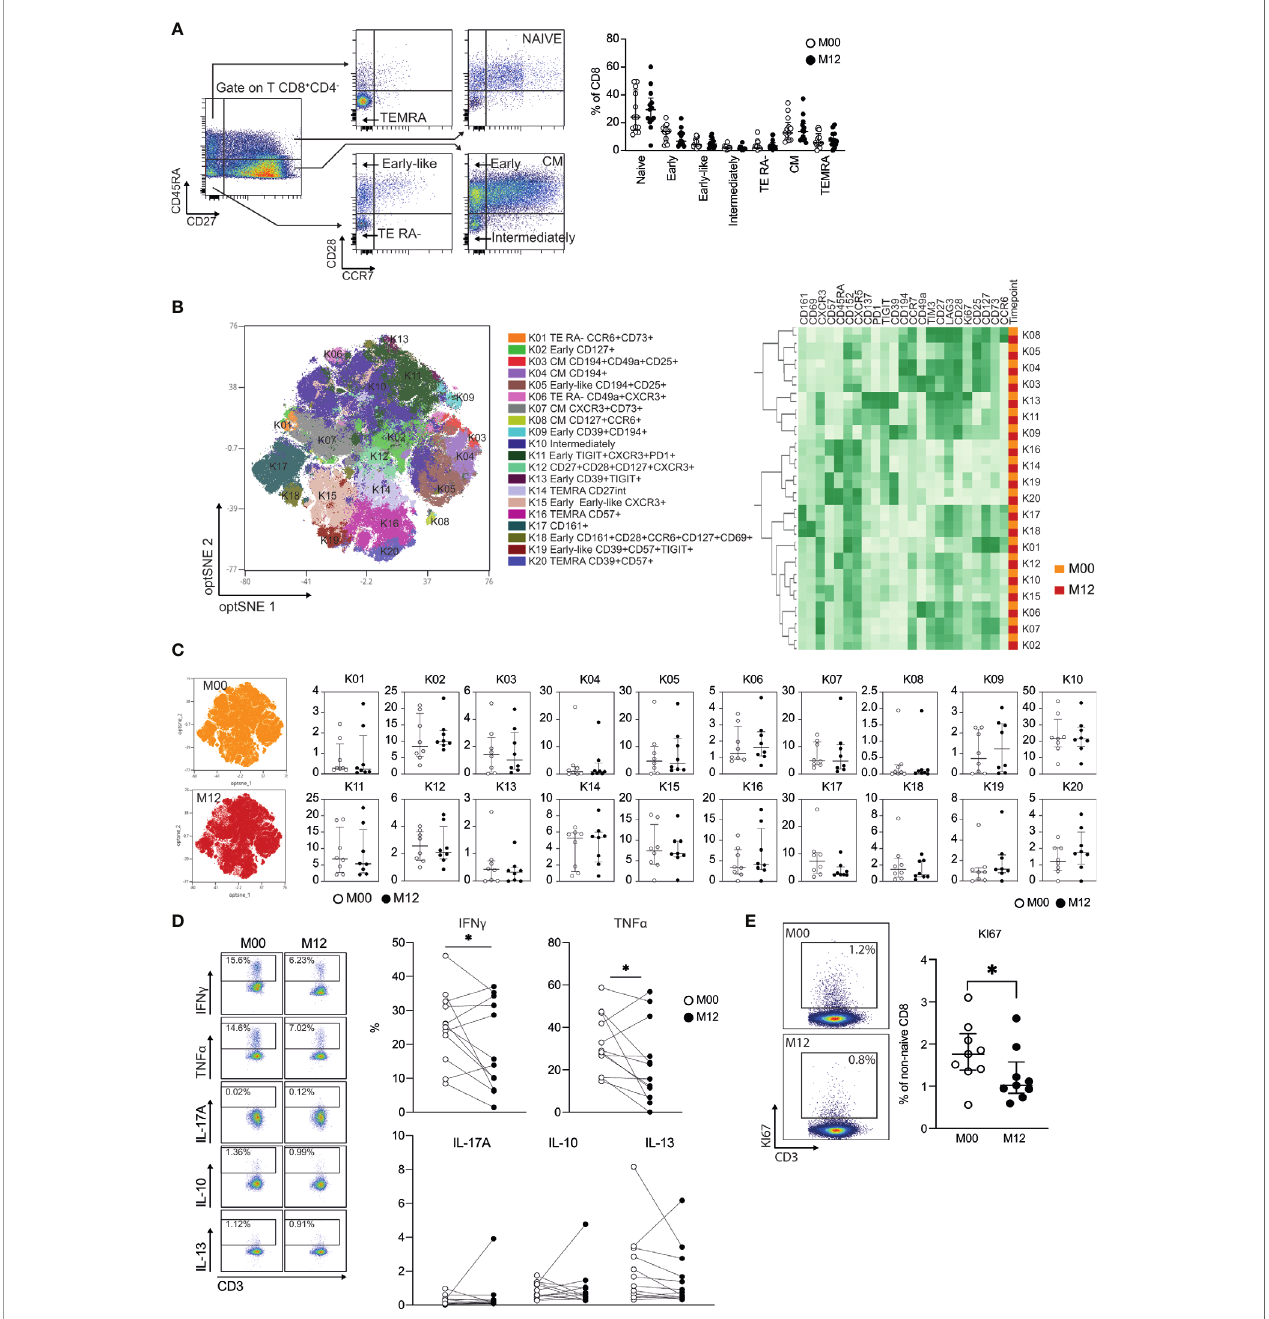
FIGURE 2 | Teri fl unomide speci fi cally reduces the proliferation and immune function of CD8 T cells in patients with RRMS. (A) Frequency of CD8 T cell subsets in patients with RRMS at baseline (white) or 12 months post-teri fl unomide treatment (black; n=13). The gating strategy is shown after initial gating of CD19 - CD56 - CD3 + TCR gd - CD8 + CD4 - cells (TEMRA, CD45RA + CD27 - CCR7 - CD28 - ; NAÏVE, CD45RA + CD27 + CCR7 + CD28 + ; early-like, CD45RA - CD27 - CCR7 - CD28 + ; EM RA-, CD45RA - CD27 - CCR7 - CD28 - ; early, CD45RA - CD27 + CCR7 - CD28 + ; intermediate, CD45RA - CD27 + CCR7 - CD28 - ; CM, CD45RA - CD27 - CCR7 + CD28 + ). (B) optSNE projection of non-naïve ab CD8 T cell clusters identi fi ed by FlowSOM metaclustering (left) and mean fl uorescence intensity (MFI) as indicated (column-scaled z- scores) for the FlowSOM cluster (right). (C) Global optSNE projection of non-naïve ab CD8 T cells for all participants pooled, with non-naïve ab CD8 T cells of patients with RRMS at M00 (white) and M12 post-teri fl unomide treatment (black) concatenated and overlaid. Percentage of non-naïve ab CD8 T cells from each timepoint in each FlowSOM cluster. (D) T H 1 cell (IFN g , TNF a ), T H 2 cell (IL-13), T REG (IL-10) and T H 17 cell (IL-17) cytokine production by CD8 T cells of patients with RRMS at M00 (white) and M12 post-teri fl unomide treatment (black) after polyclonal restimulation. (E) KI67 expression in non-naïve ab CD8 T cells. (A, C – E) Each dot represents a unique patient, and the median and interquartile ranges (IQRs) are shown. Signi fi cance was determined by unpaired Mann-Whitney U or paired Wilcoxon test (*p <